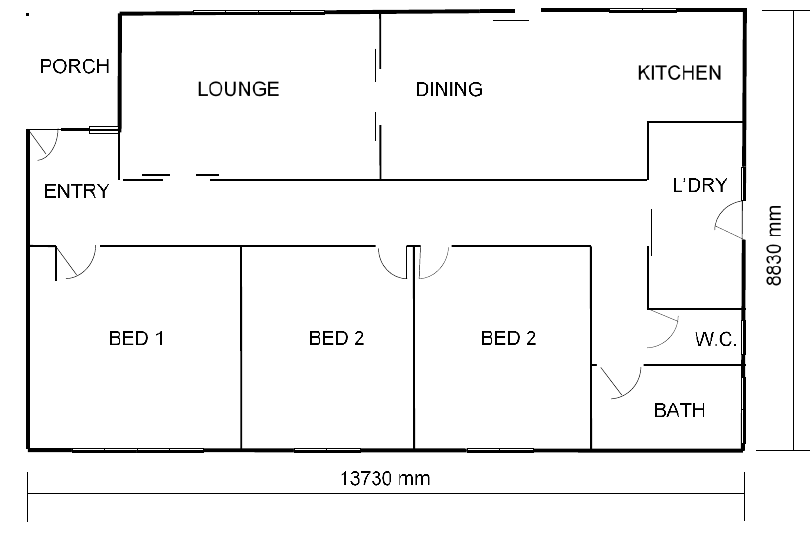
Figure 2. A reference house based on Reference [20].